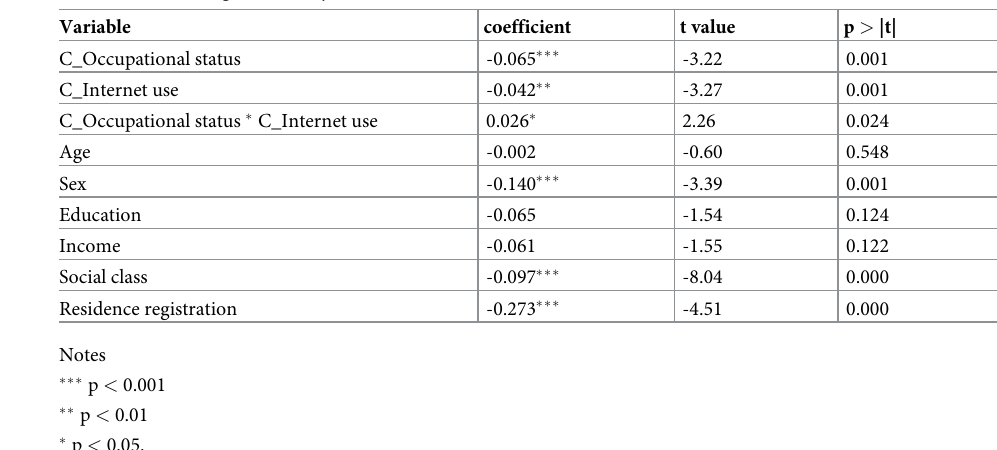
Table 3. Moderating effect analysis (N =